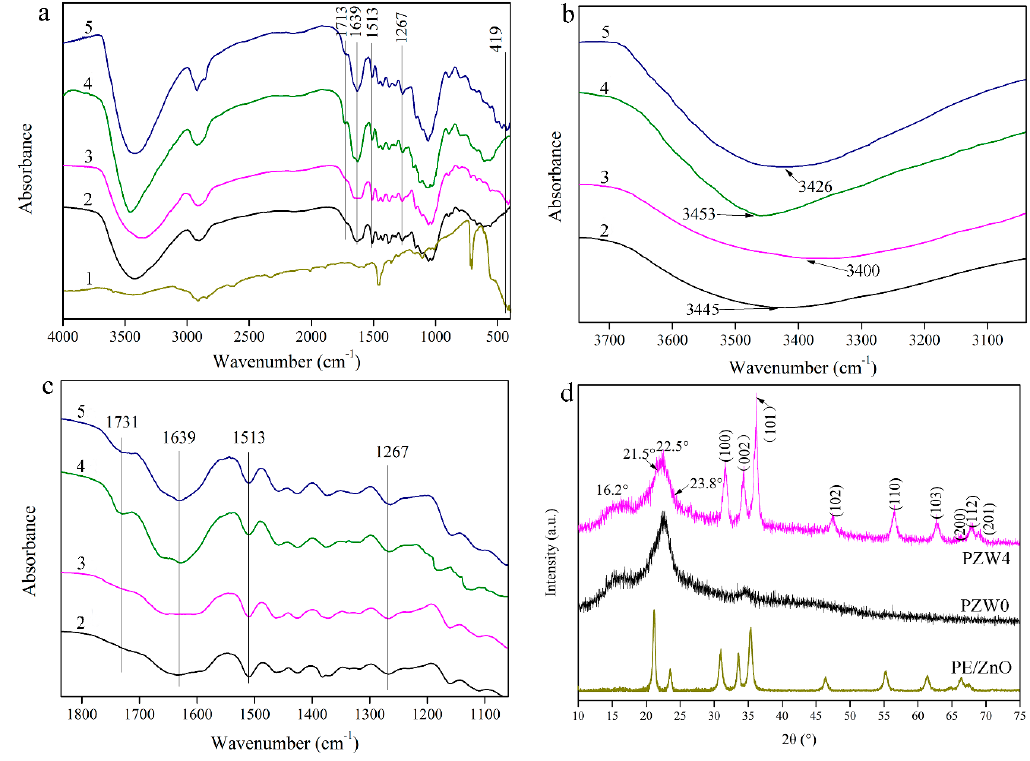
Figure 3. ( a – c ) The FTIR spectra of PE/ZnO (1), PZW0 (2), PZW4 (3), PZW0 without hot-pressing (4), Figure and PZW4 without hot-pressing (5); ( d ) The XRD patterns of the PE/ZnO, PZW0, and PZW4 composites.